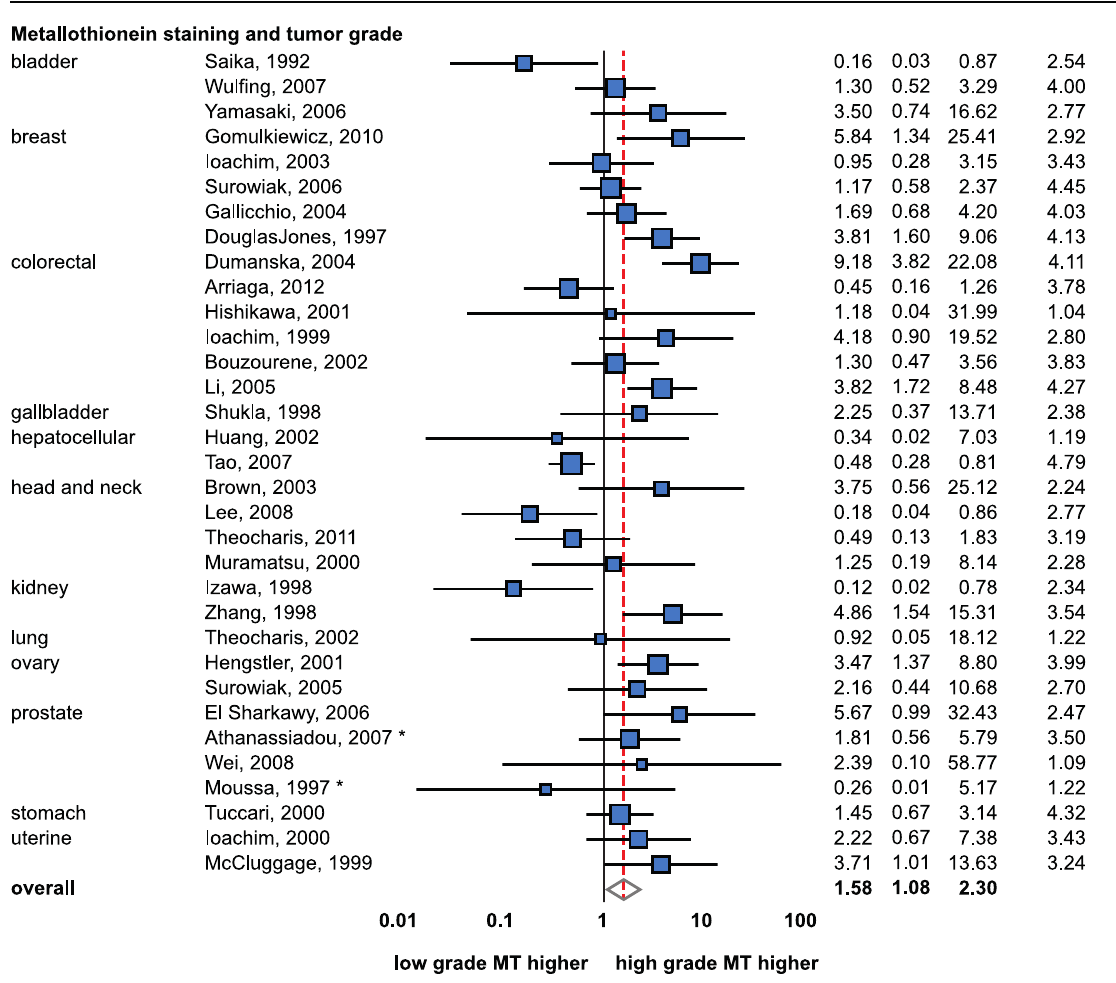
Figure 4. Forrest plot of studies reporting the association of metallothionein staining and tumor grading. Random effects model used. Relative weight of individual studies displayed in %. For more detailed results see Table 1 and 2. * indicates studies using Gleason grading. Sorted alphabetically by tumor types. Forrest plot displayed as odds ratio and 95% confidence intervals. Red dashed line indicates the result for all studies together. OR, odds ratio; CI, confidence interval.